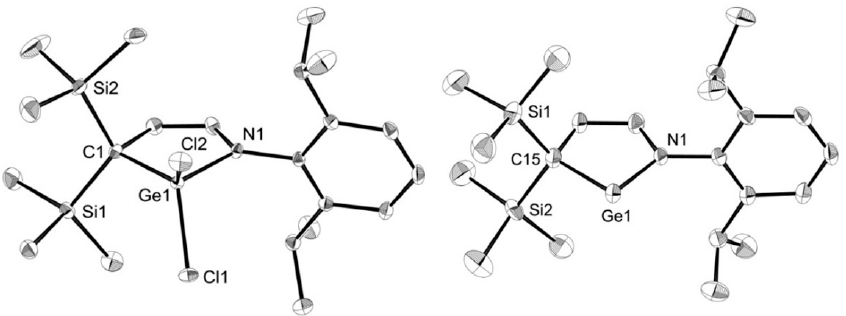
Figure 3. Solid state structures of 2 ( left ) and 3 ( right ). Hydrogen atoms are omitted for clarity. Thermal ellipsoids are shown at the 50% probability level.